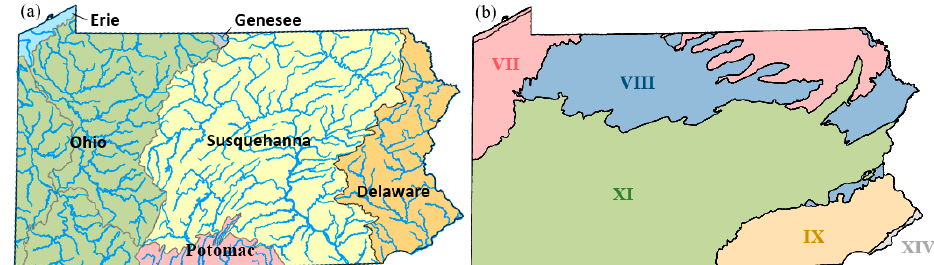
Figure 2. ( a ) Streams within major river basins and ( b ) aggregate nutrient ecoregions of Pennsylvania, USA. See text for ecoregion names and